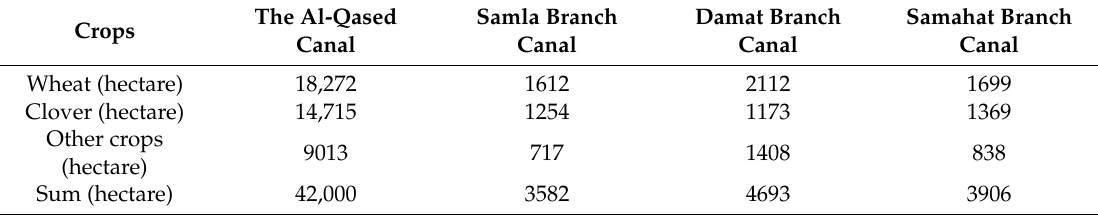
Figure 1. Study area map showing the location of the Al-Qased canal, branch canals, and land uses. Table 1. Crop patterns of The Al-Qased canal and the Samla, Damat, and Samahat branch canals.